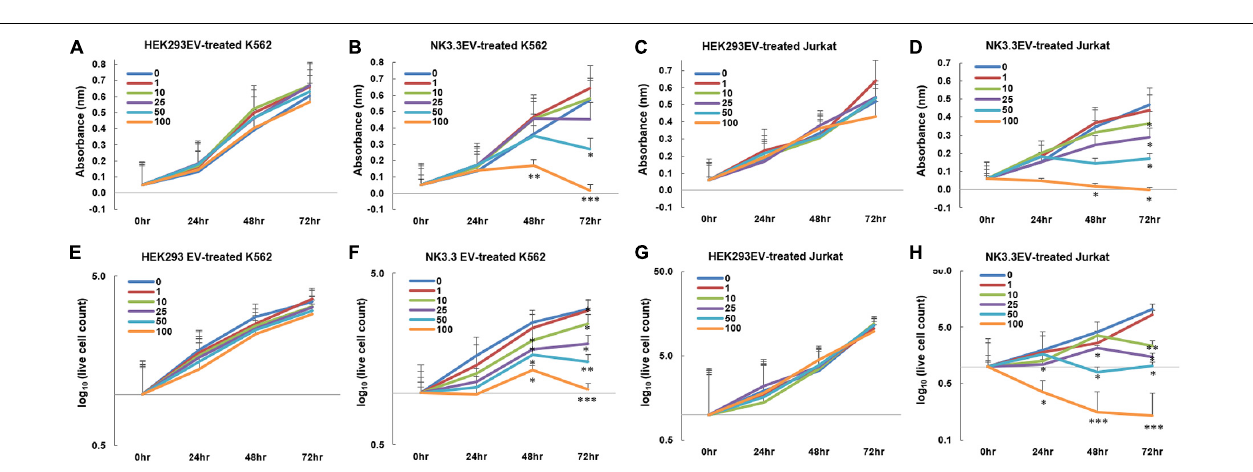
FIGURE 4 | Inhibition of leukemia cell growth and metabolic activity by NK3.3-derived EV treatment in vitro. (A–H) Dose response analyses were performed using concentrations of EVs ranging from 1 to 100 µ g/ml or PBS (0). Absorbance measurements using the WST-1 cell viability assay were assessed in K562 cells treated with either (A) HEK293 EVs or (B) NK3.3 EVs, and Jurkat cells treated with either (C) HEK293 EVs or (D) NK3.3 EVs. Mean absorbance ± SE; n = 3. Corresponding live cell counts, determined by automated cell counting using trypan blue dye exclusion, were performed at the same time as the WST-1 measurements for